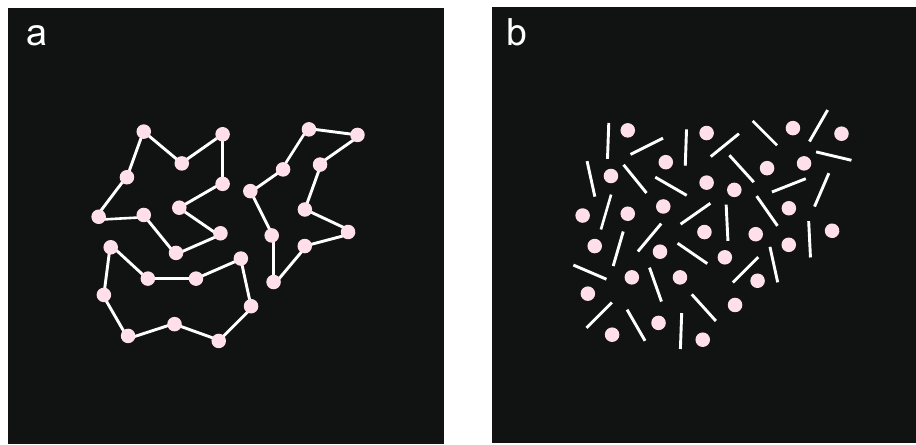
Figure 3. Representation of the test stimulus with unconnected ( a ) and connected ( b ) elements. Food elements are represented by pink dots and inedible lines by white